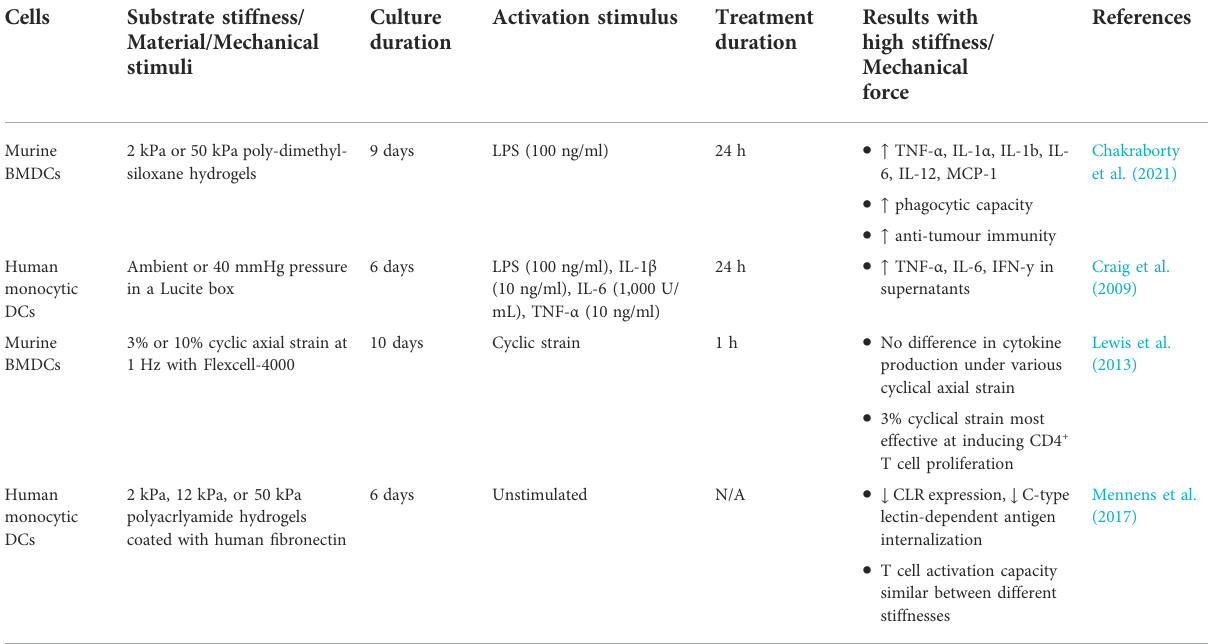
TABLE 3 Summary of effect of mechanical stimuli on the effector function of